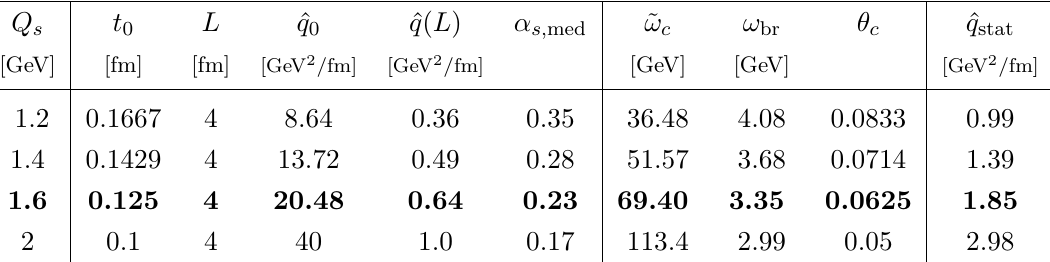
Table 1. Set of parameters that we consider throughout this paper. The values of α s, med are adjusted so as to obtain a good description of the R AA jet nuclear suppression factor (see section 5). The row highlighted in bold corresponds to our default